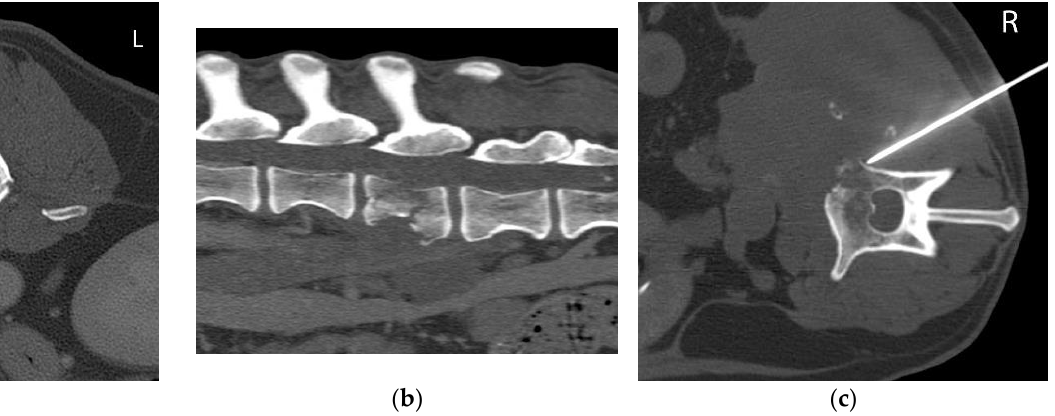
Figure 3. Case 6, 13-year-old Weimaraner with a polyostotic aggressive bone lesion (L3 and L4) associated to a hypaxial soft tissue mass consistent with a sarcoma. ( a ) Transverse and ( b ) sagittal multiplanar reconstruction (MPR) of the lumbar spine in a bone window. There is a large soft tissue mass in the right hypaxial muscles infiltrating the vertebral body and transverse processes of L3 and L4 and invading the retroperitoneal space. There is a pathological fracture of L3 vertebral body with vertebral compression; ( c ) Transverse MPR at the level of L3 in a bone window. There is evidence of a spinal needle in the hypaxial mass and the lytic L3 vertebral body, introduced in a right dorsolateral approach.